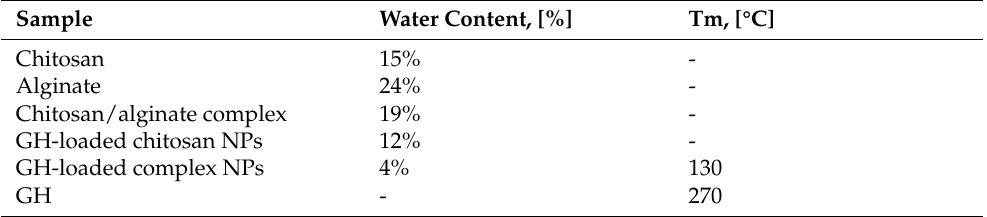
Table 2. Water contents in pure and drug-loaded samples as well as in their constituents.